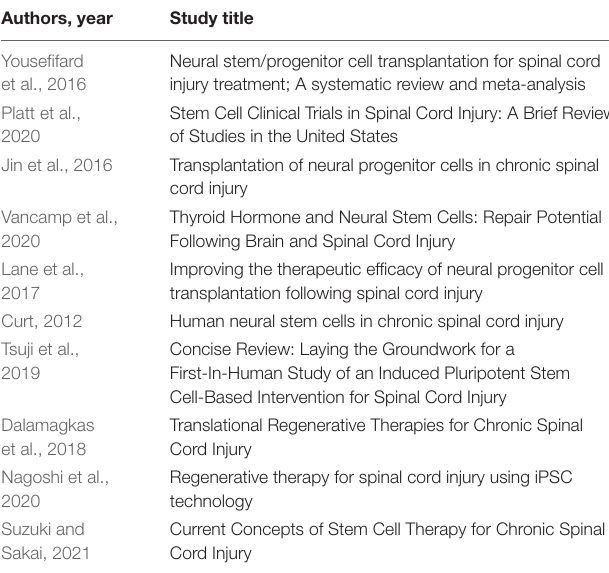
TABLE 5 | Promising attempts, limitations and discussing points in NSC/NPC treatment for chronic